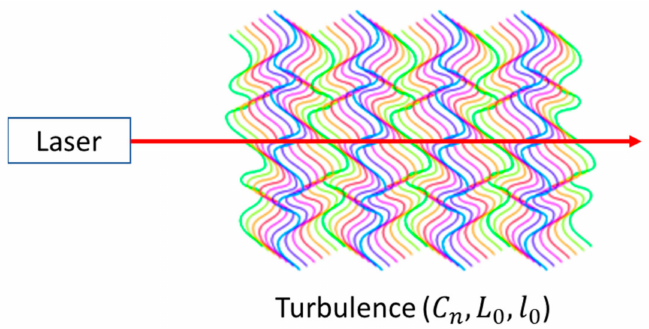
Figure 19. Laser beam performance characteristic through atmospheric turbulence [28,47].